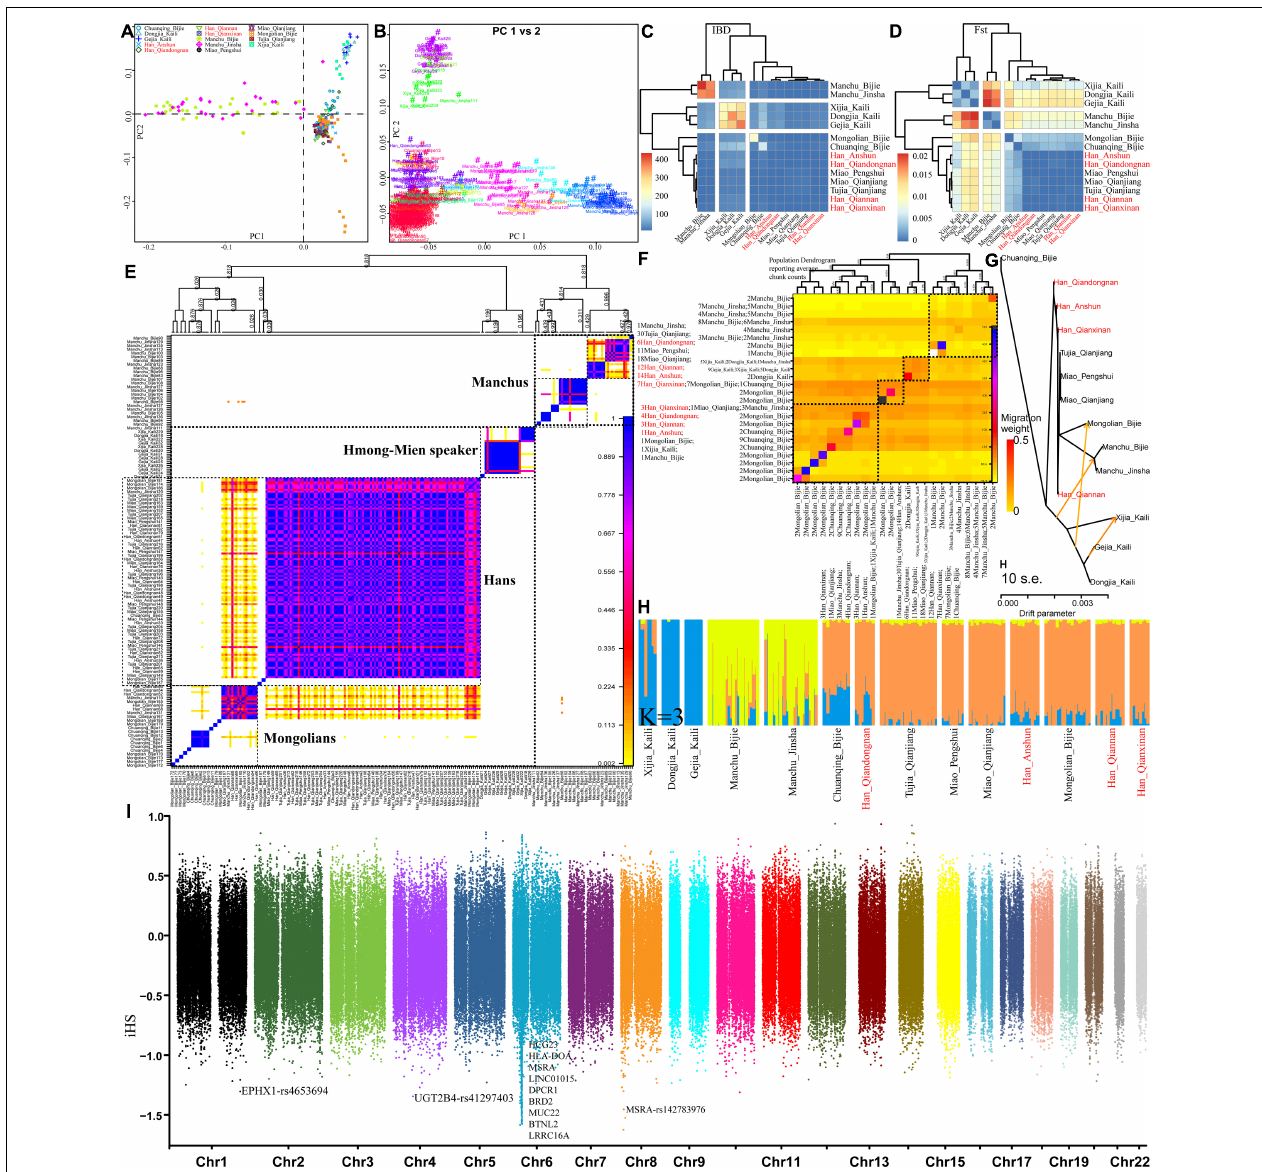
FIGURE 8 | Finer-scale genetic characteristics within 28 southwestern populations. PCA results based on the allele frequency (A) and the shared haplotypes (B) . Heatmap was visualized based on the pairwise Fst genetic distance (C) and the shared IBD segments (D) ; individual (E) or population (F) clustering patterns inferred from the co-ancestry matrix in the fineSTRUCTURE analysis; descriptive analysis results from the TreeMix-based phylogeny (G) and model-based admixture results (H) ; natural selection signals inferred from the iHS (I) .